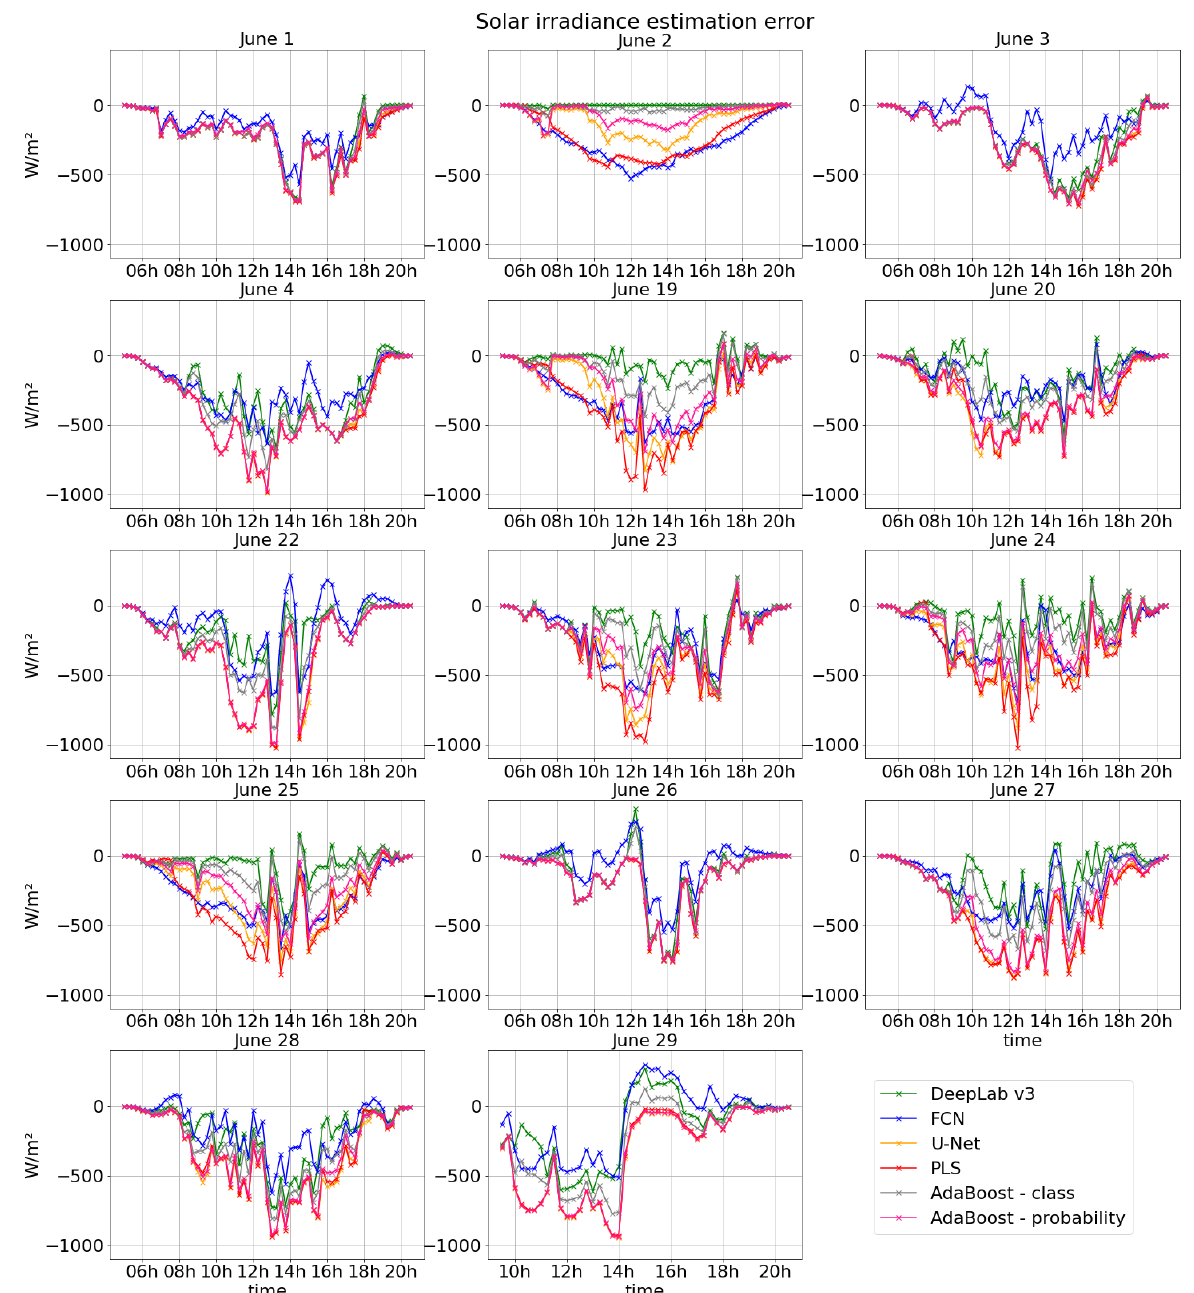
Figure A4. Solar irradiance estimation error in W/m 2 for 14